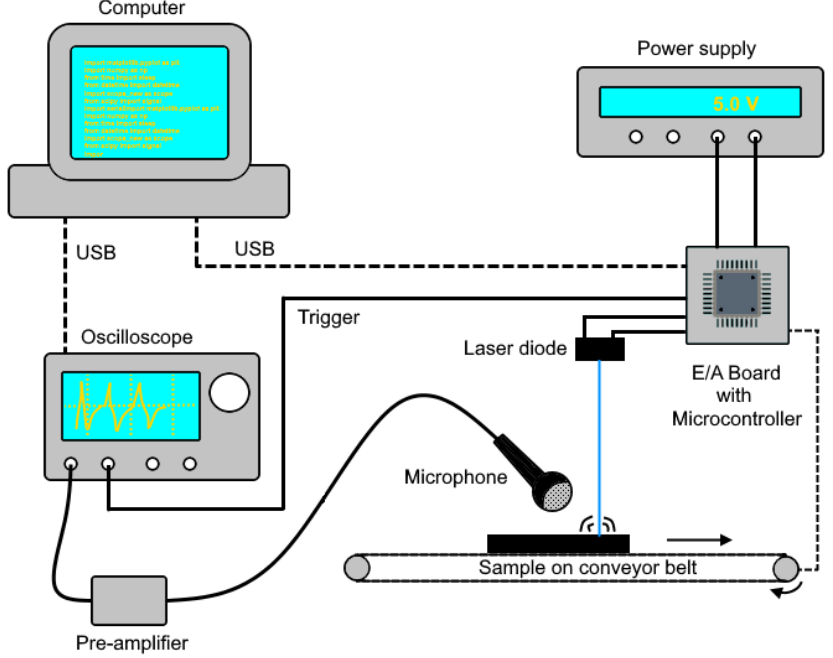
Figure 1. Experimental setup for laser-acoustic measurements.